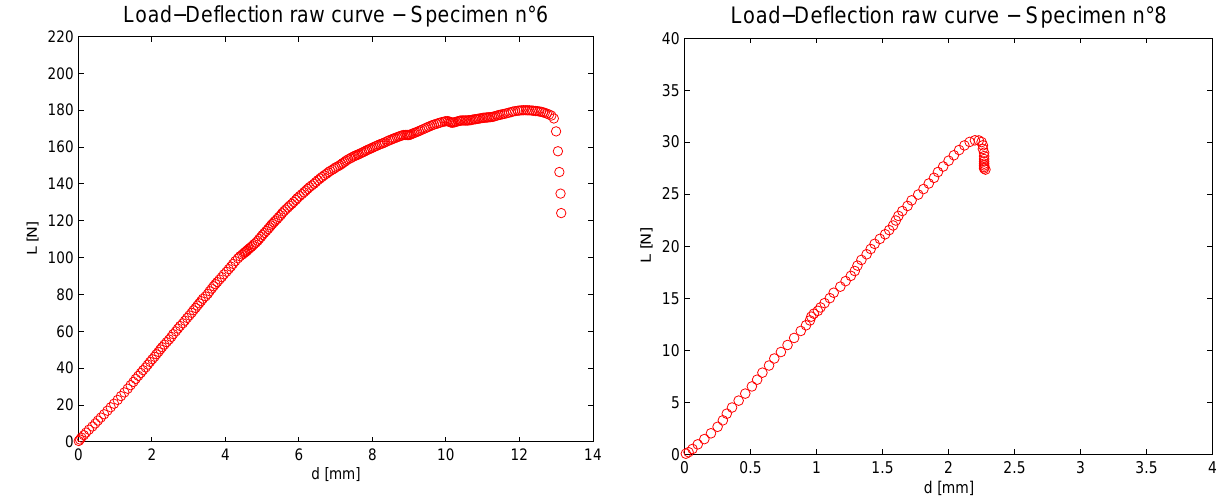
Figure 6: Raw load-deflection curve for specimen 6.